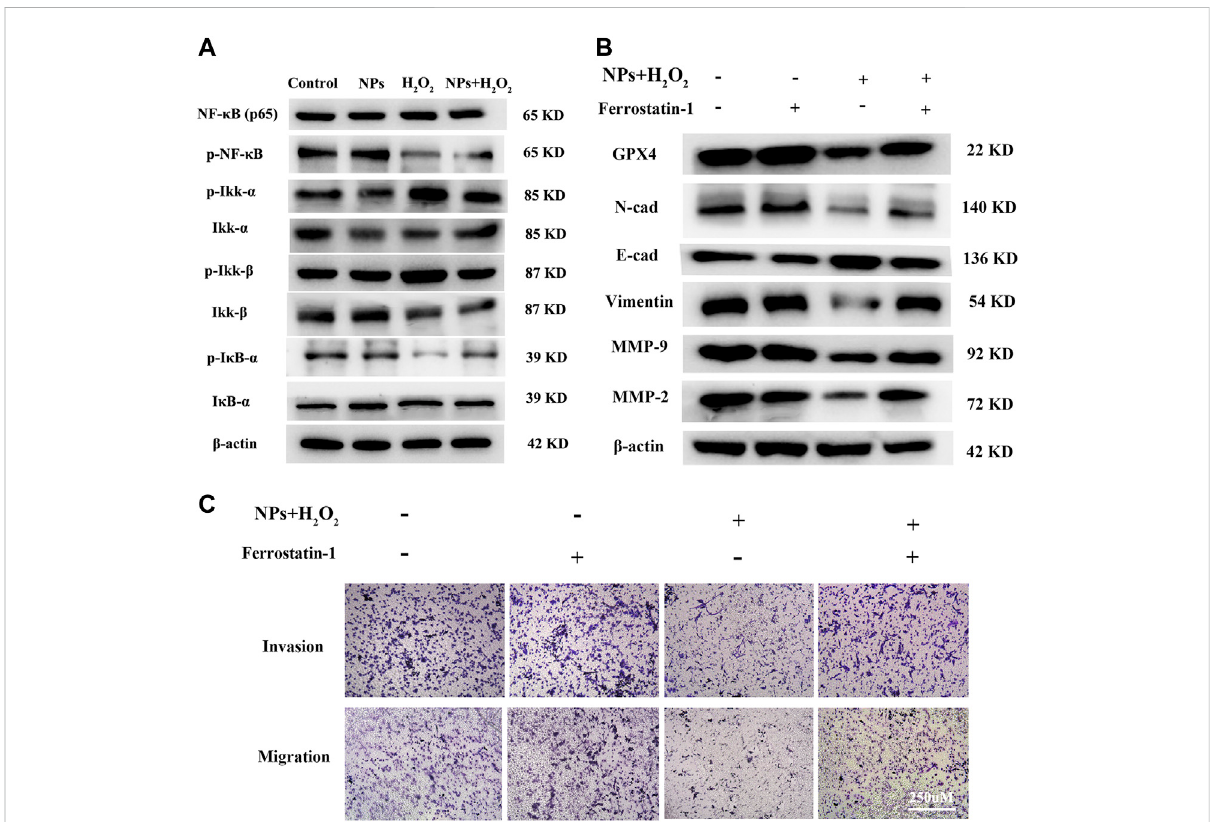
FIGURE 5 PPy@ Fe 3 O 4 NPs suppress CRC cells metastasis by promoting cell ferroptosis and inhibiting NF- κ B signaling pathway. (A) Western blot. ColorectalcancercelllineDLD1wastreatedwithvariousgroups(Control,H 2 O 2 ,NPsandNPs+H 2 O 2 ),andthensubjectedtoWesternblotanalysisof the key proteins of the NF- κ B signaling pathway (Ikk- β , p-Ikk- β , Ikk- α , p-Ikk- α , NF- κ B, p-NF- κ B, i κ B- α , and p-i κ B- α ). (B) Effects of the